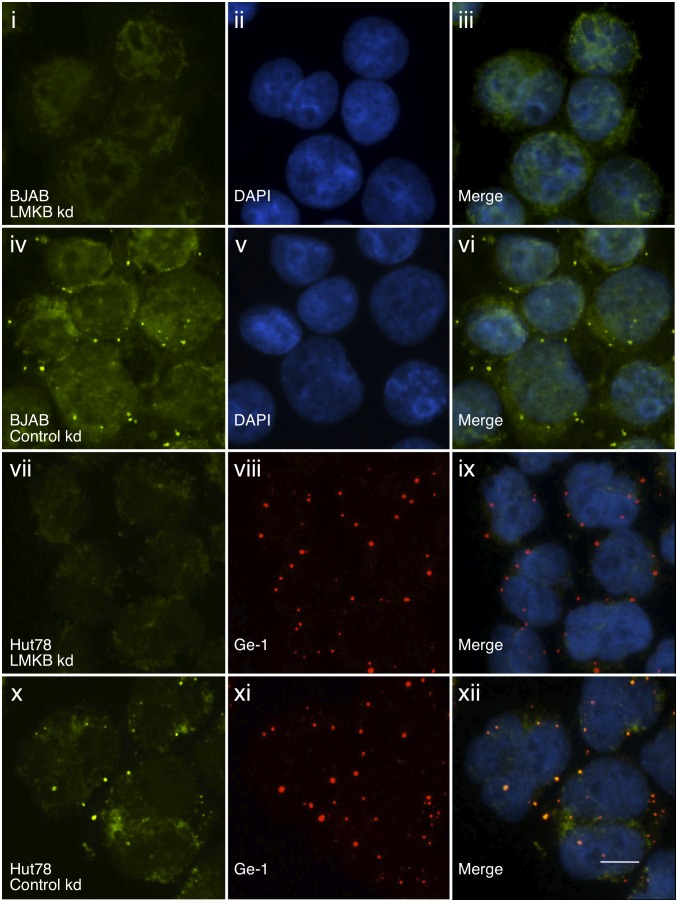
Loss of LMKB immunoreactivity after LMKB knockdown in BJAB and Hut78 cells.Treatment of BJAB cells with siRNA directed against LMKB resulted in loss of P-body staining as determined by indirect immunofluorescence (i). LMKB was detected in a cytoplasmic dot staining pattern in cells treated with control siRNA (green, iv). DAPI staining (blue) in ii and v indicate the location of nuclei. Merge of the preceding panels is shown in iii and vi. Treatment of Hut78 cells with siRNA directed against LMKB also resulted in loss of cytoplasmic dot staining (vii), compared with cells treated with control siRNA (green, x). Loss of LMKB did not alter the cellular location of Ge-1-containing P-bodies (red, viii and xi) demonstrating that LMKB is not required for P-body formation. Merge of vii and viii, and x and xi, is shown in ix and xii. DAPI staining (blue) in the merged panels indicates the location of nuclei. White bar in xii indicates 5.0 µm.